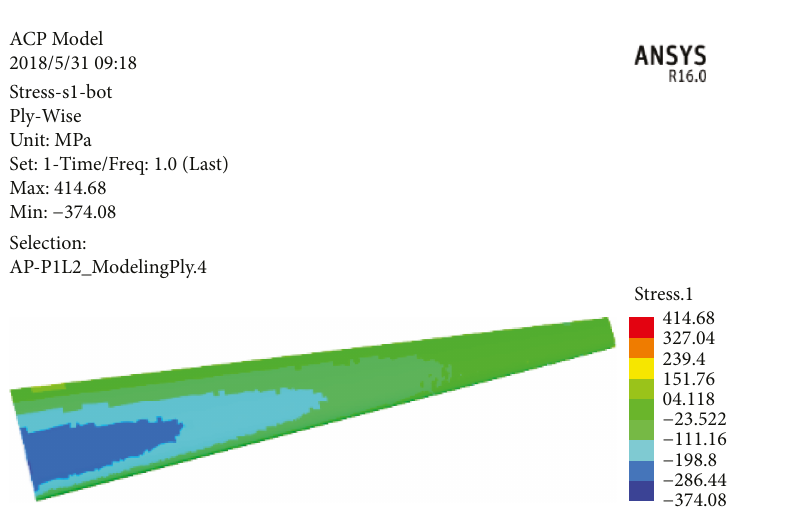
Figure 45: Stress cloud diagram of the upper wing with the layer ratio being 20%/20%/60%.